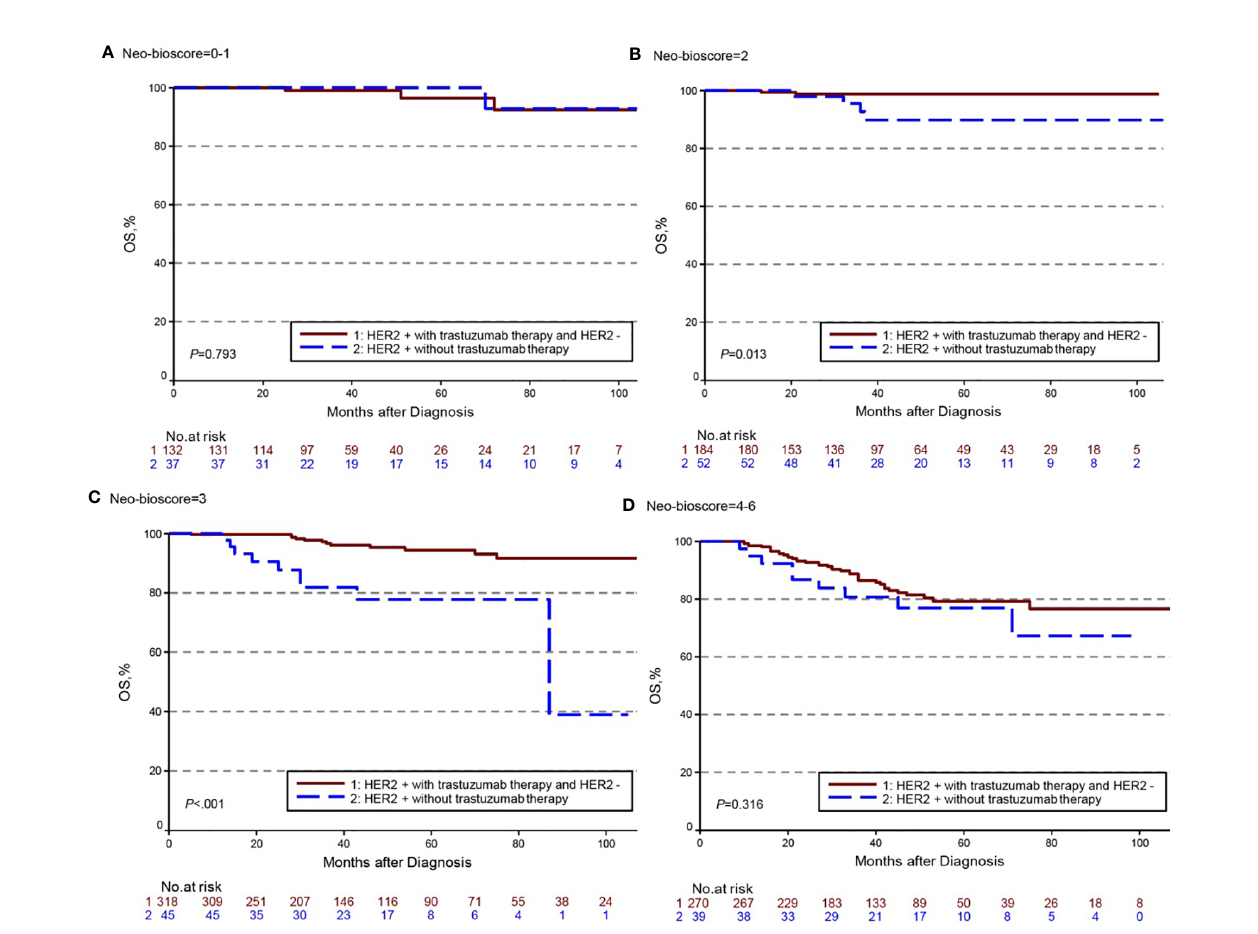
FIGURE 6 | Kaplan – Meier survival curves for overall survival (OS) determined by the Neo-Bioscore staging system for different HER2 status subgroup. Group 1: HER2-positive patients with trastuzumab therapy and HER2-negative patients; Group 2: HER2-positive patients without trastuzumab therapy. (A) OS of different HER2 status subgroup in Neo-Bioscore scores 0 and 1; (B) OS of different HER2 status subgroup in Neo-Bioscore score 2; (C) OS of different HER2 status subgroup in Neo-Bioscore score 3; (D) OS of different HER2 status subgroup in Neo-Bioscore scores 4, 5, and